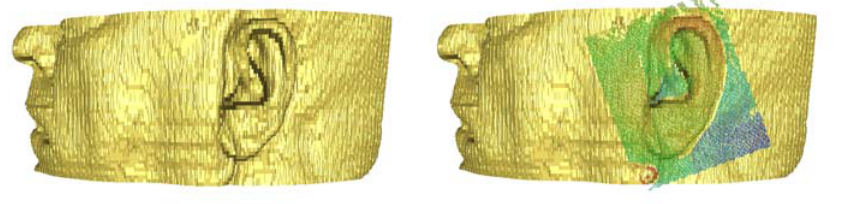
Fig. 7 Surface reconstruction of auricular soft tissue from CT data (left), with laser surface scan superimposed